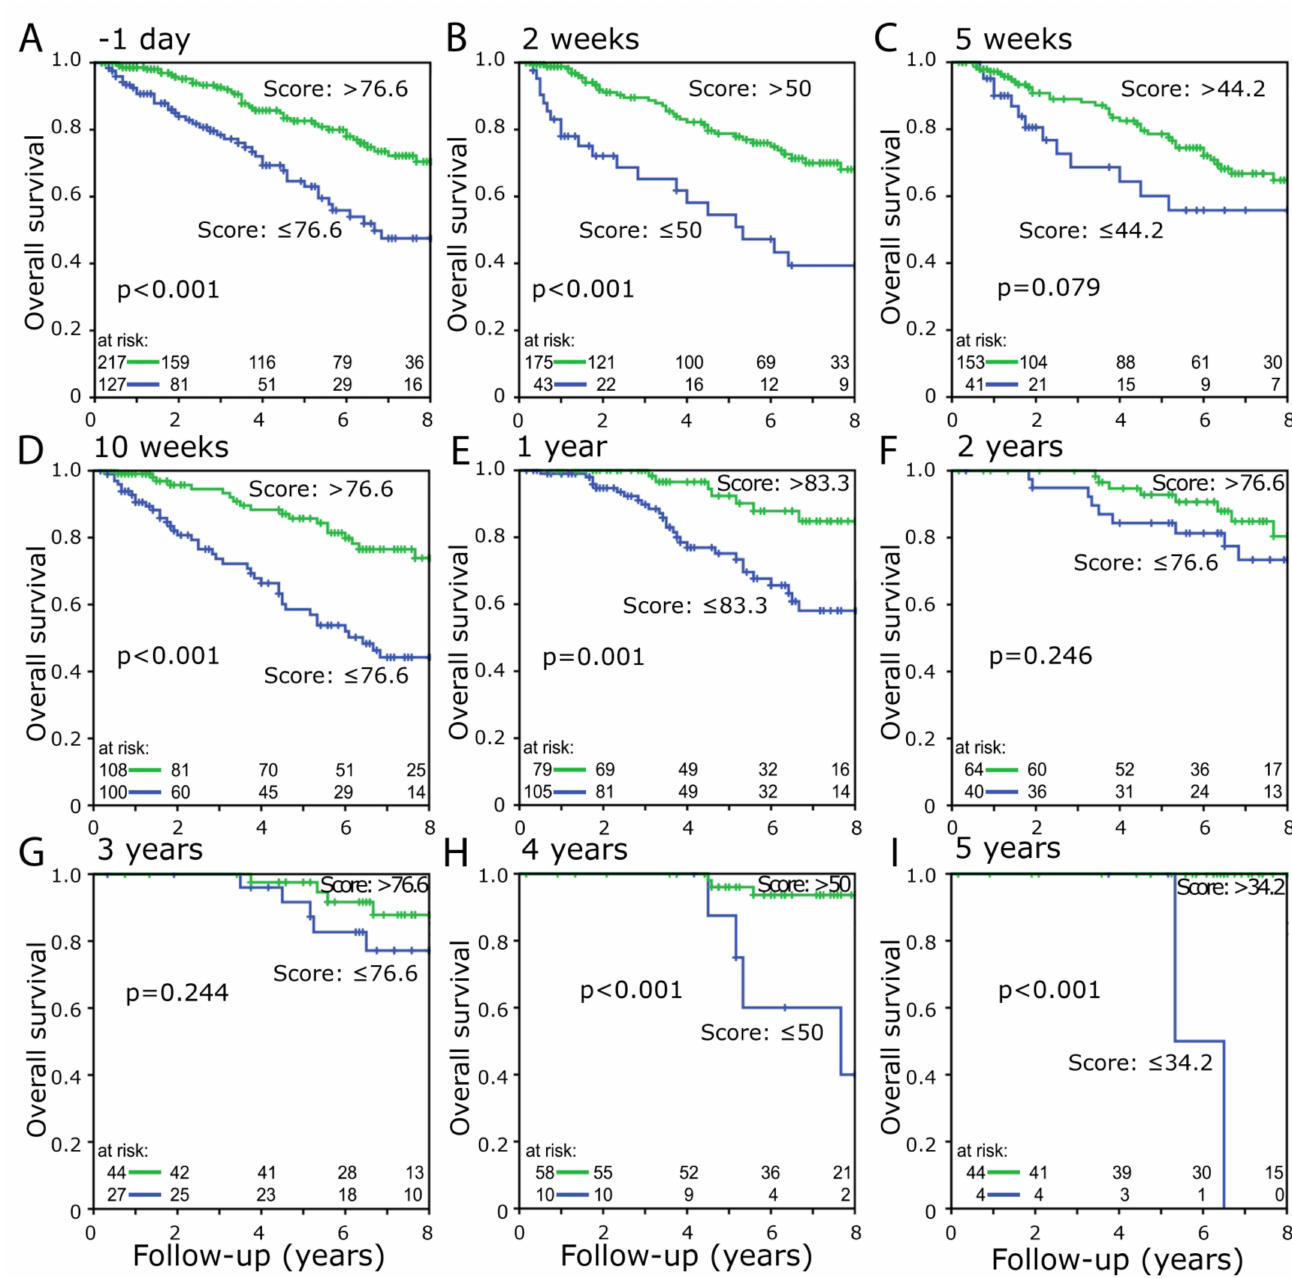
Figure 5. Overall survival between the group with higher (green line) and lower (blue line) scor- ing “physical function” with respective cutoff values at the different dates ( A ) day -1, ( B ) week 2, ( C ) week 5, ( D ) week 10, ( E ) 1 year, ( F ) 2 year, ( G ) 3 year, ( H ) 4 year, ( I ) 5